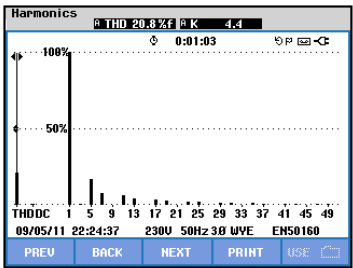
Figure 12. FFT analysis of distorted grid current with inductive load and without any filtering ac- tion.